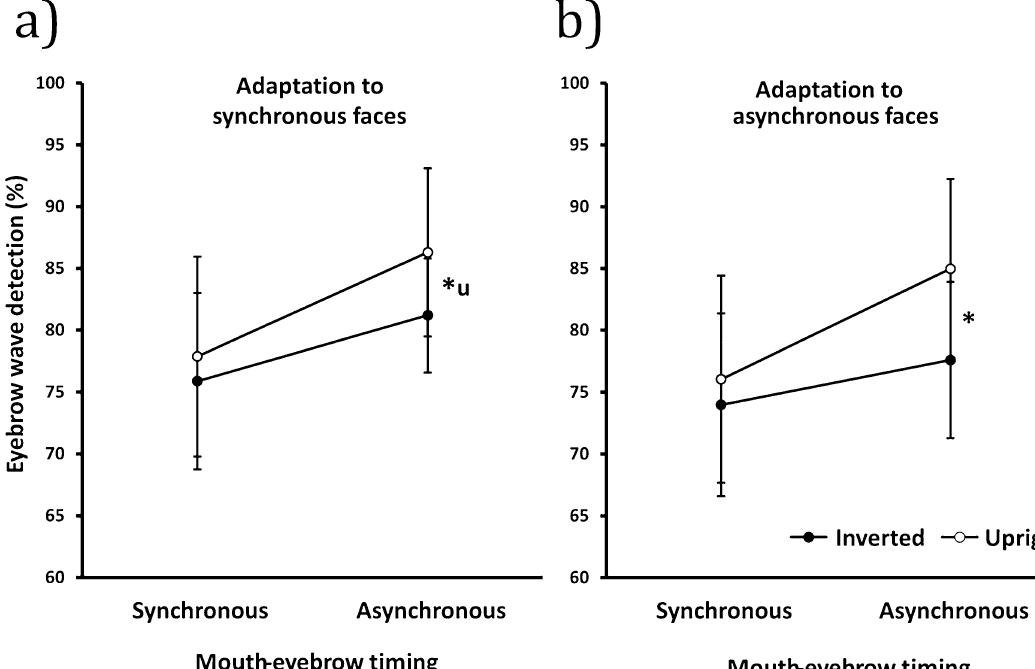
Figure 3. Percent correct for eyebrow wave detection as a function of test synchronicity after (a) adaptation to synchronous facial motion, and (b) adaptation to asynchronous facial motion. Closed circles = inverted faces, open circles = upright faces. Overall the eyebrow wave was harder to detect during synchronous test movement as in Experiment 1 ( F (1,13) = 16.27, p = .001, η p 2 = 0.56). Also, performance was reduced after asynchronous adaptation relative to synchronous adaptation ( F (1,13) = 4.93, p = .045, η p 2 = 0.28). There was also a main effect of orientation indicating an overall face inversion effect, with impaired eyebrow wave detection for inverted faces ( F (1,13) = 5.93, p = .030, η p 2 = 0.31). However, the inversion effect was greater for asynchronous tests than synchronous tests ( F (1,13) = 6.90, p = .021, η p 2 = 0.35) and it did not depend upon adaptation conditions ( F (1,13) = .248, p = .627, η p 2 = 0.02). Post-hoc paired-samples t-tests indicated that the inversion effect